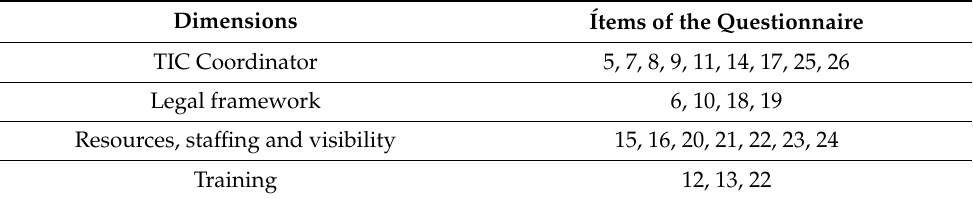
Table 5. Dimensions of the questionnaire. Dimensions Í tems of the Questionnaire